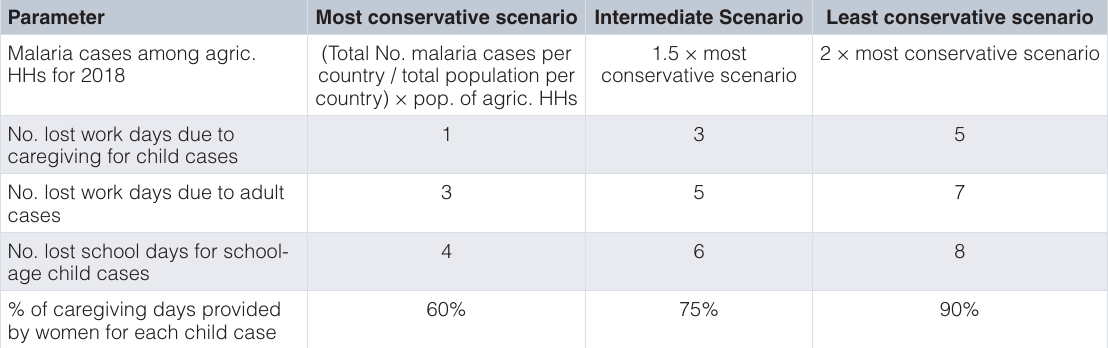
Table 3. Summary of parameter values for each scenario.